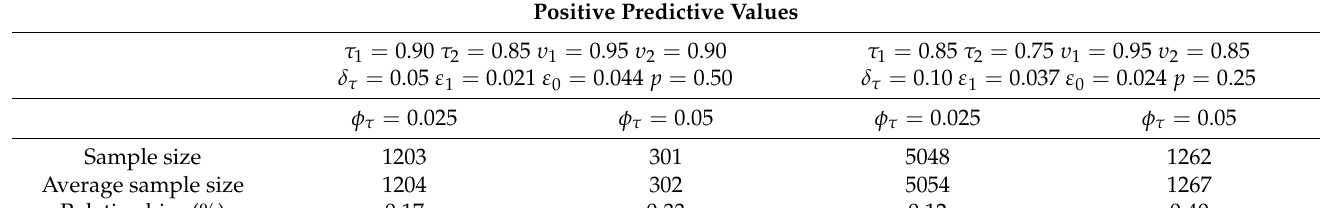
Table 6. Sample size for estimated the difference between the positive (negative) predictive values. Positive Predictive